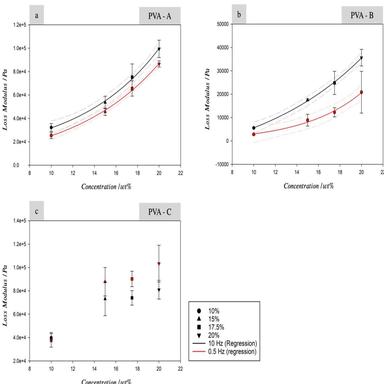
Loss Modulus plotted against concentration for 0.5 Hz (red), and 10 Hz (black) for PVA-A (a), PVA-B (b), and PVA-C (c). Error bars show 95% confidence (n = 6). Regression lines for 0.5 Hz (red), and 10 Hz (black) are also given; dashed lines show 95% confidence intervals for regression. (For interpretation of the references to colour in this figure legend, the reader is referred to the web version of this article.)